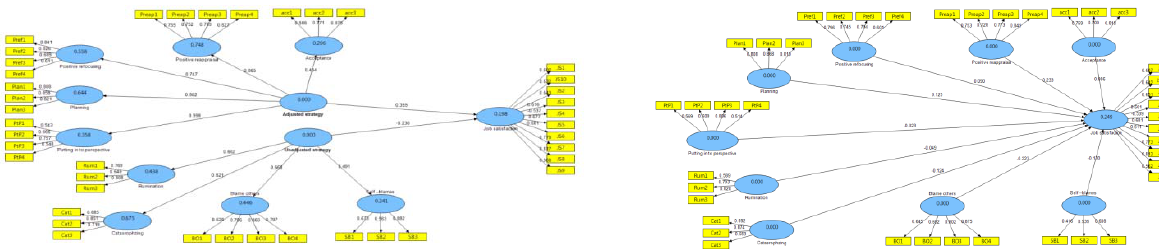
Fig. 2. Results of PLS structural model analysis (Smart PLS export image)